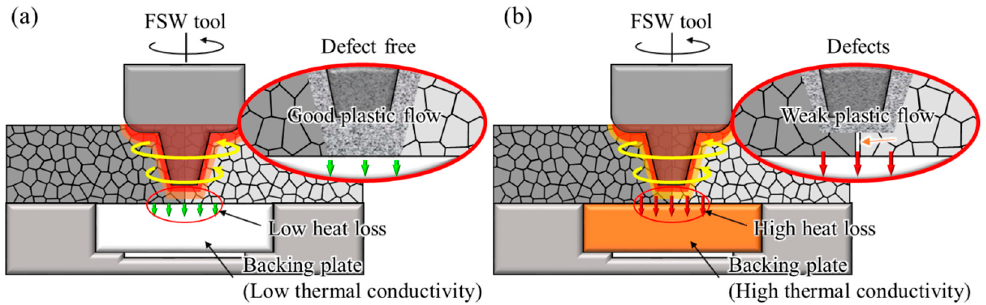
Figure 1. Schematic illustration of the mechanism of heat loss to the backing plate using a backing plate with ( a ) a low thermal conductivity and ( b ) a high thermal conductivity.